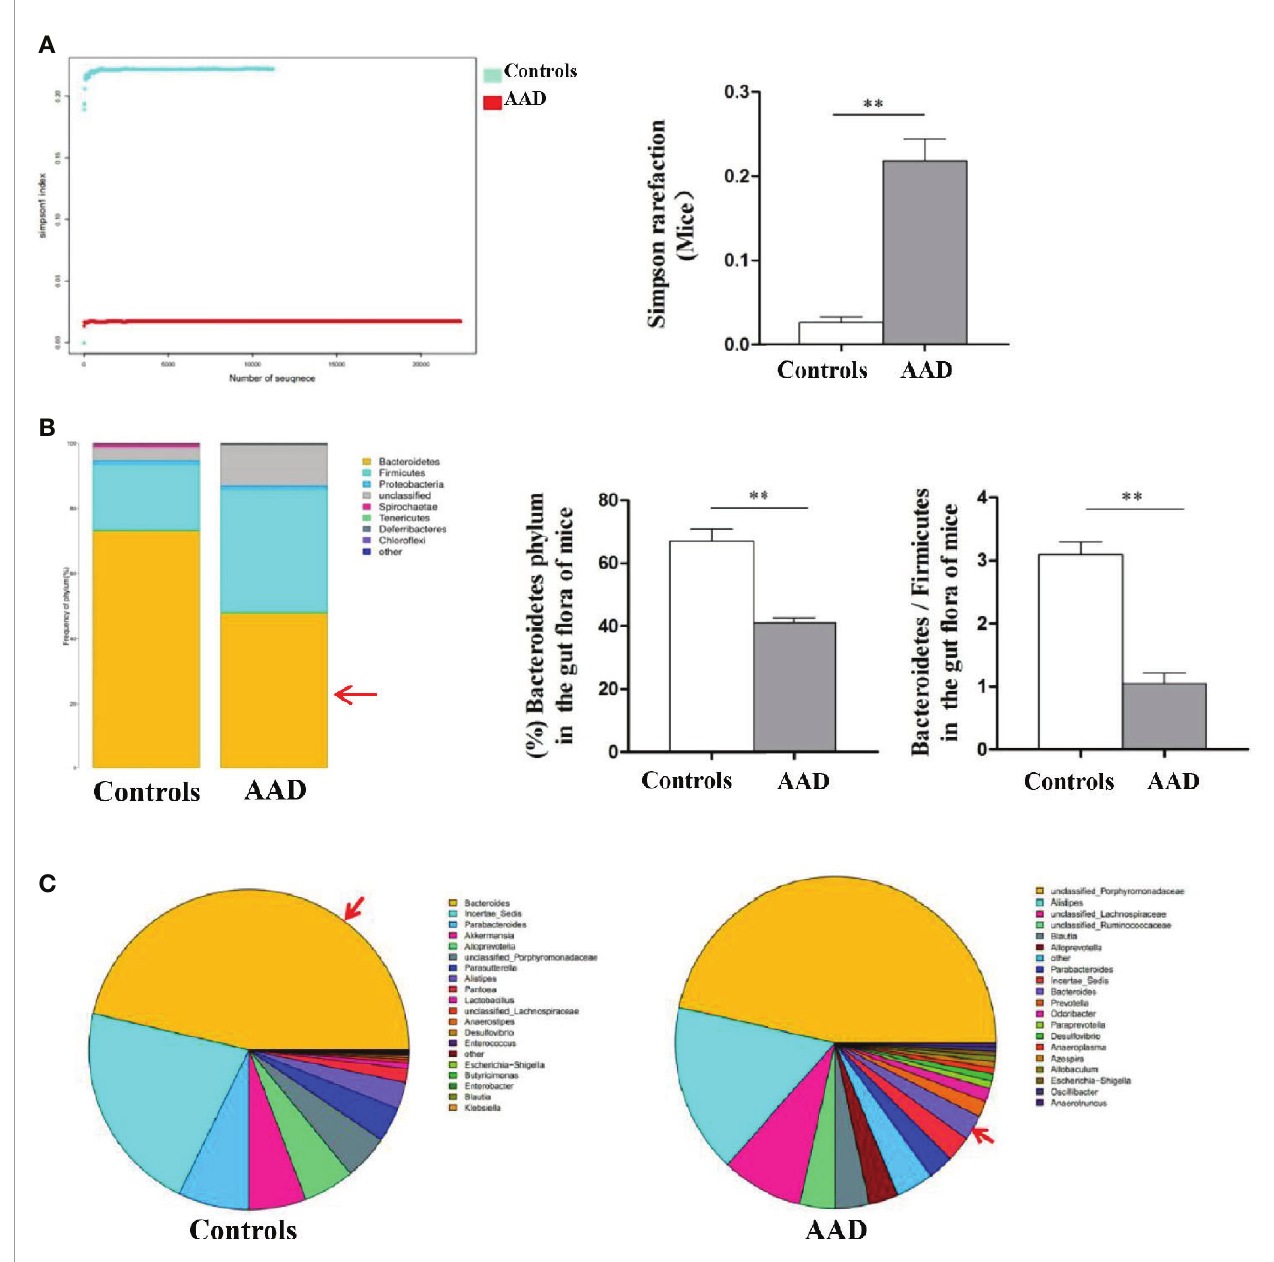
FIGURE 3 | The diversity and abundance of intestinal micro fl ora in murine model of OVA-induced allergic airway in fl ammation. (A) The Simpson rarefaction in AAD mice increased. (B) Bacterial composition and abundance at the phylum level. Red arrow: Bacteroidetes. (C) Bacterial composition and abundance at the genus level. Red arrow: Bacteroides. Bar graphs represent mean ± SD (n = 6). ** P <